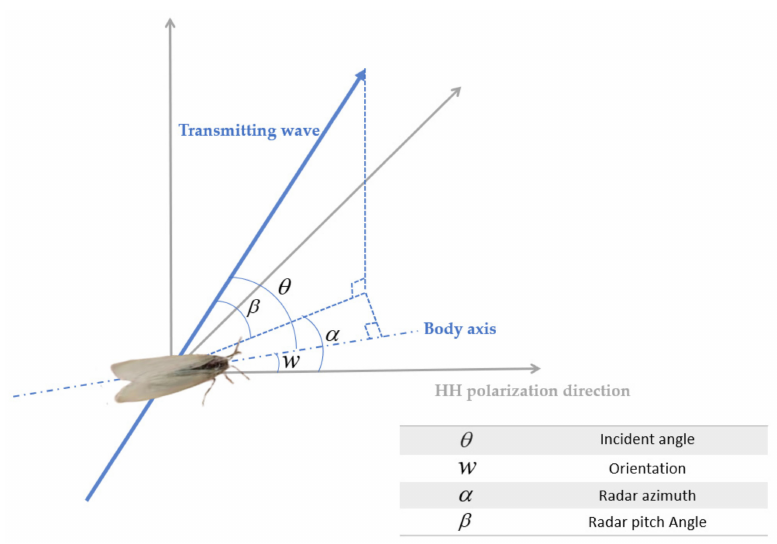
Figure 6. The geometric relationship between orientation and incident angle.